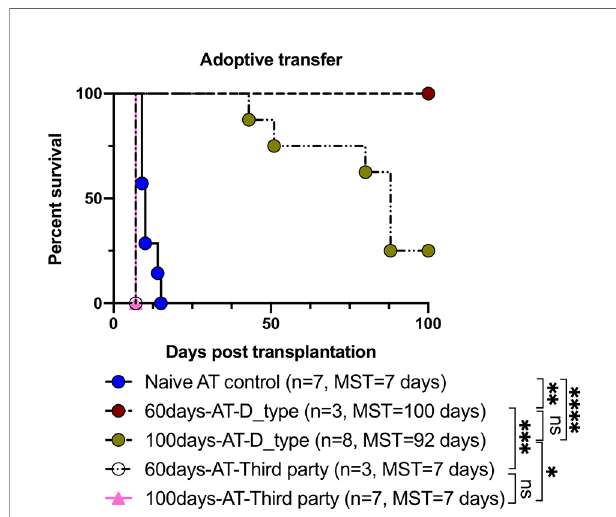
FIGURE 5 | Tolerance induced by FR70 resulted in the acceptance of secondary donor-type cardiac grafts after adoptive splenocyte transfer. The splenocytes harvested at POD60 and 100 from the C3H recipients bearing B6 grafts were adoptively transferred into naïve C3H mice, which were then given B6 (donor type) or BALB/c (third party) cardiac allografts. The graft survival after adoptive transfer of splenocytes is shown (n = 7 mice for Naïve AT control group, n = 3 mice for 60 days-AT-D_type group, n = 8 mice for 100 days-AT-D_type group, n = 3 mice for 60 days-AT-Third party group, n =7 mice for 100 days-AT-Third party group, pooled from two independent experiments). Table 2 shows the detailed graft survival data. A statistical evaluation of the graft survival was performed using Kaplan – Meier curves with a comparison using log-rank tests. *p < 0.05, **p < 0.01, ***p < 0.001, ****p < 0.0001.